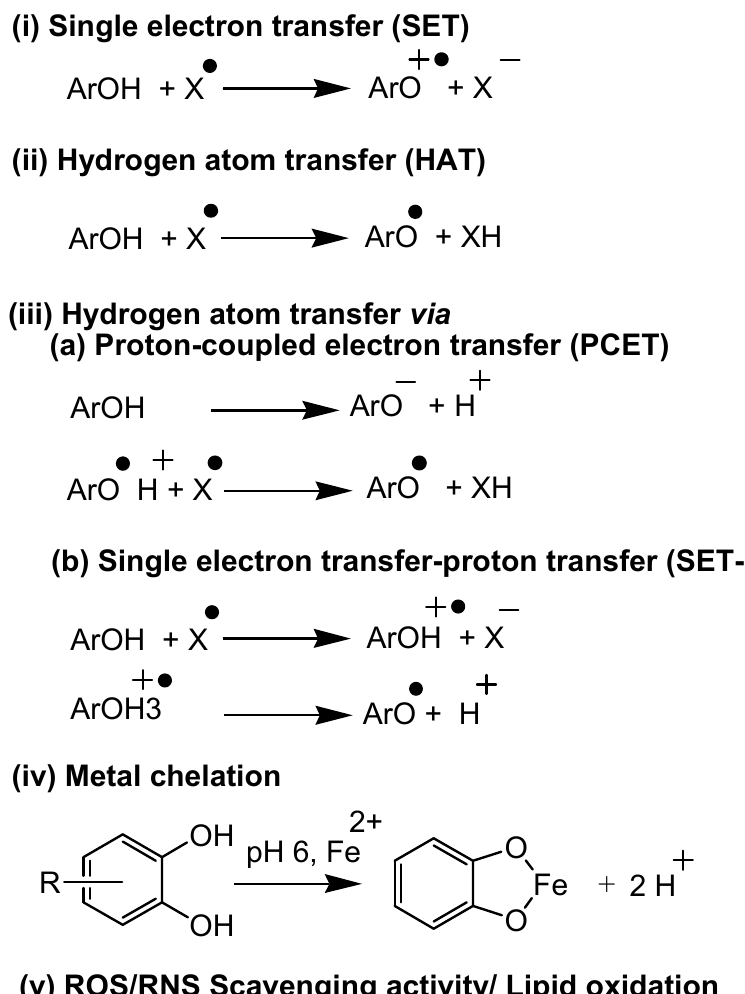
Figure 3. Mechanistic aspects of antioxidant assays both in vitro and in